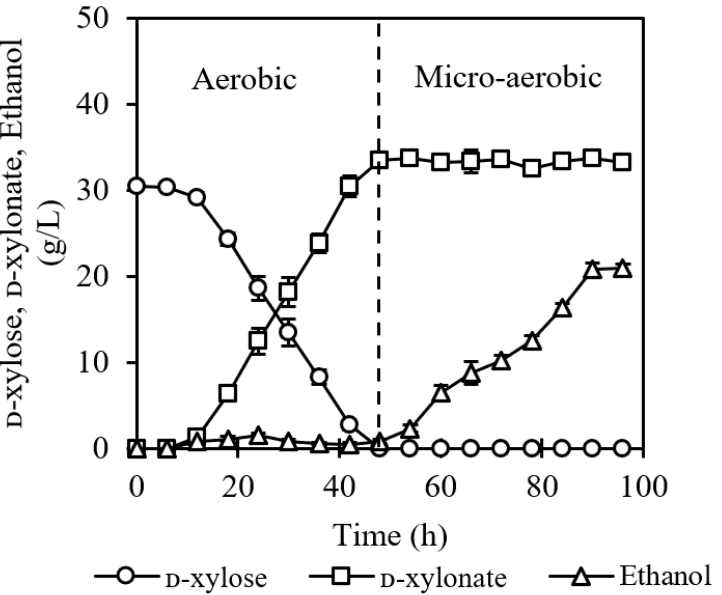
Figure 4. Sequential production of D -xylonate and ethanol from non-detoxified acid-pretreated corncob by a two-stage fermentation strategy.